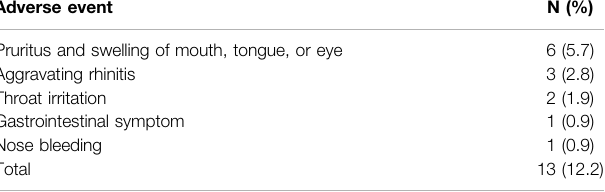
TABLE 3 | Different minor adverse events during the SLIT. Adverse event N (%) Pruritus and swelling of mouth, tongue, or